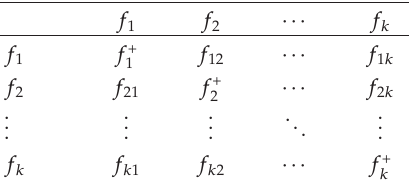
Table 1: First pay-o ff table.